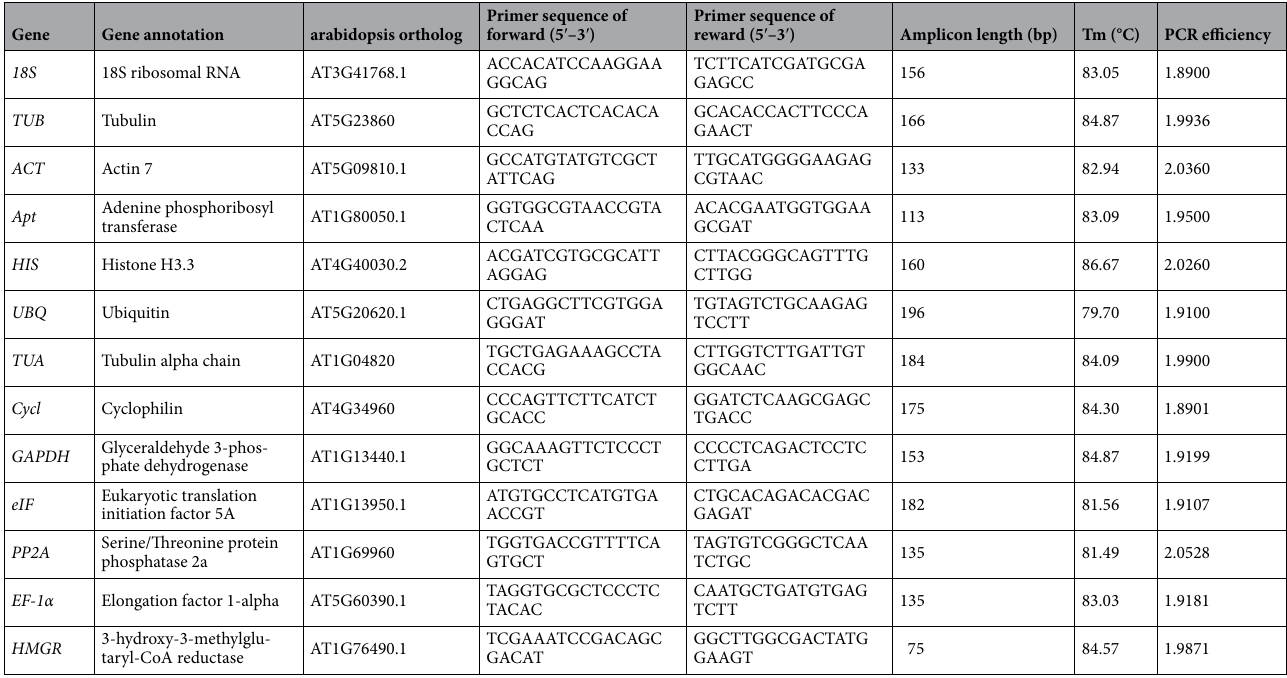
Table 1. Gene description, primer sequences, amplicon length, and PCR efficiency for I. rubescens candidate reference